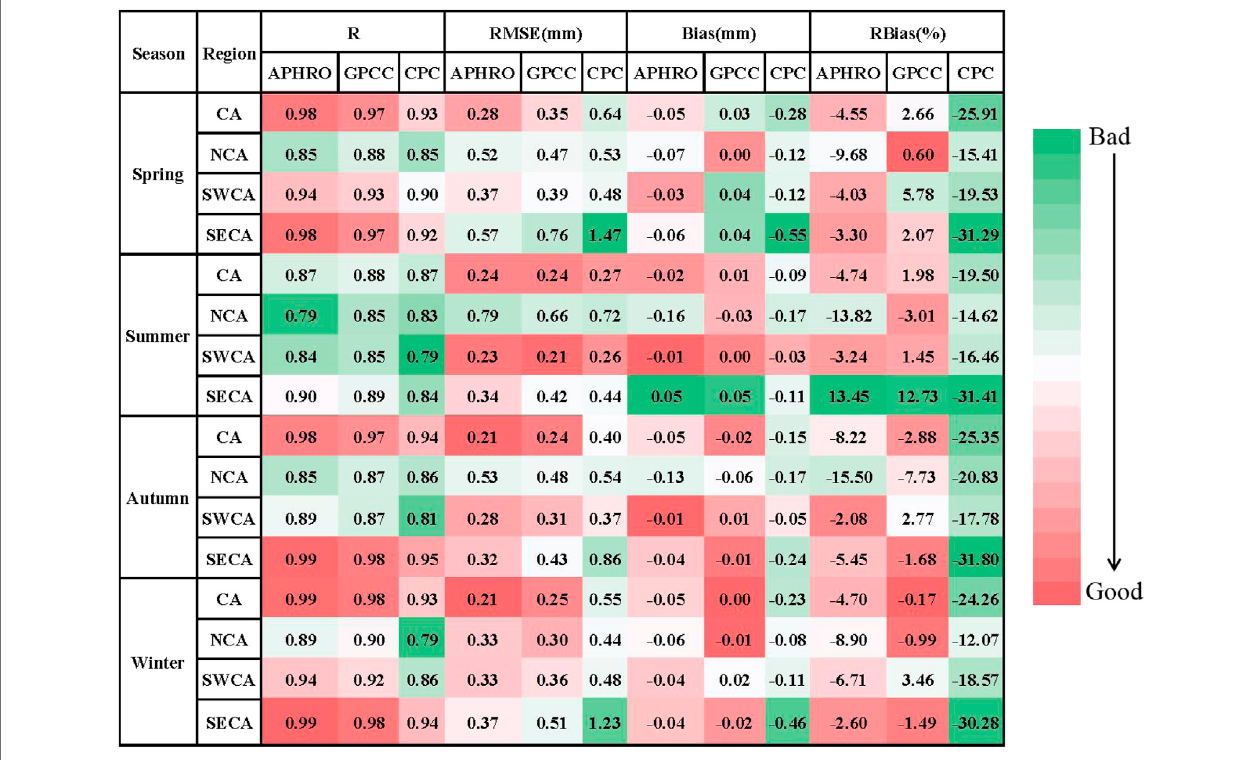
Frontiers in Earth Science |